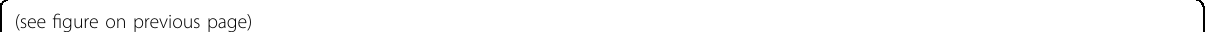
Fig. 3 p62 siRNA treatment preserved a higher number of RGCs than rapamycin treatment did 2 weeks after ONC. a Representatives of fl at- mounted central and midperipheral retina and the morphometry of RGCs labeled by retrograde tracer in each group ( n = 6 per group). b RGC density of the central retina and midperipheral retina in each group. Data are expressed as the mean ± SD in each group ( n = 6). The numbers of RGCs in the central and midperipheral retina in the p62 siRNA-treated group were 1.91-fold and 1.67-fold higher than those in the rapamycin-treated group, respectively. c Representative pictures of apoptotic cells in the RGC layer of each group. Stronger antiapoptotic effects were observed in the p62 siRNA-treated group than in the rapamycin-treated group 2 weeks after ONC. Apoptotic cells (TUNEL-positive cells/HPF; green) overlapped with nuclei of RGCs (blue) in the RGC layer. d Quanti fi cation of TUNEL-positive cells per HPF. Data are expressed as the mean ± SD in each group ( n = 6). The apoptotic cells in the p62 siRNA-treated group were signi fi cantly reduced by approximately 3.99-fold and 3.08-fold compared with those in the scrambled siRNA-treated group and rapamycin-treated group, respectively. * P <